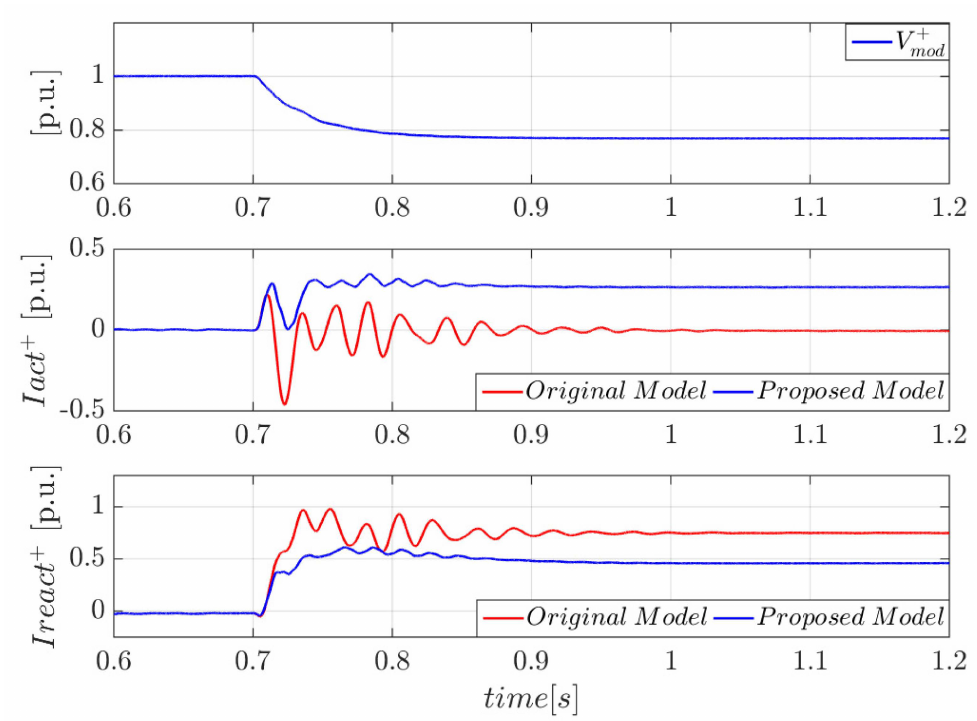
Figure 27. Positive sequence voltage and currents during the unbalanced fault for both models.